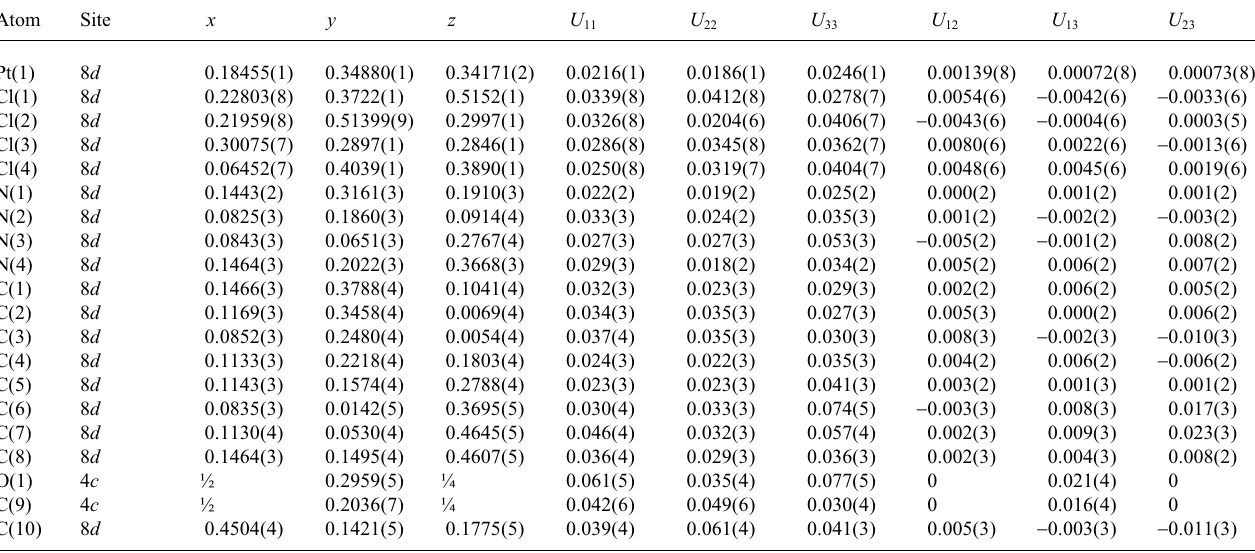
Table 3. Atomic coordinates and displacement parameters (in Å 2 )